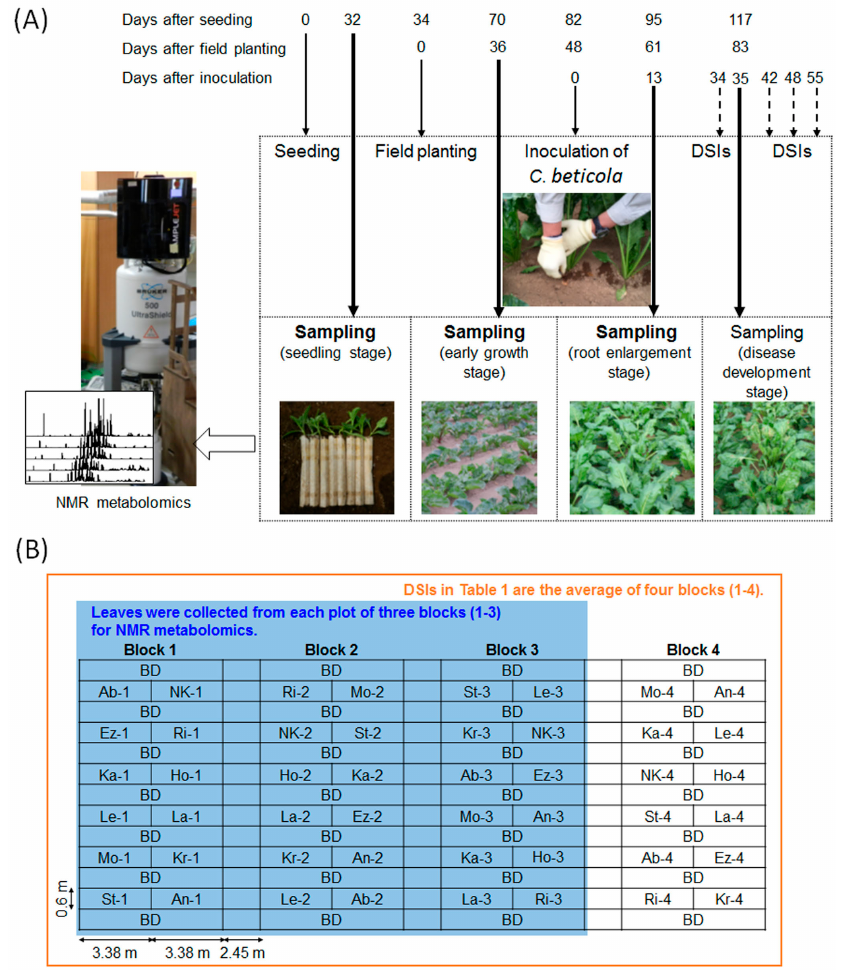
Figure 1. ( A ) Sampling timetable during field testing of Cercospora leaf spot (CLS) resistance. The thin, bold, and dashed arrows indicate the schedules for cultivation, sampling time points, and recording disease severity indices (DSIs), respectively; ( B ) Block design for the field test. The individual plot size for each genotype was 2.03 m 2 (3.38 m × 0.6 m), and the plant density was 15 plants per plot. Each plot is described by genotype abbreviation and block number. For NMR metabolomics, leaves were collected from one plant in each plot of three blocks as samples 1–3. A DSI was given to each plot of four blocks and a DSI for a sugar beet genotype in Table 1 was calculated by averaging DSIs across four blocks. BD: uninoculated border plots of the highly resistant cultivar Rivolta (Ri).